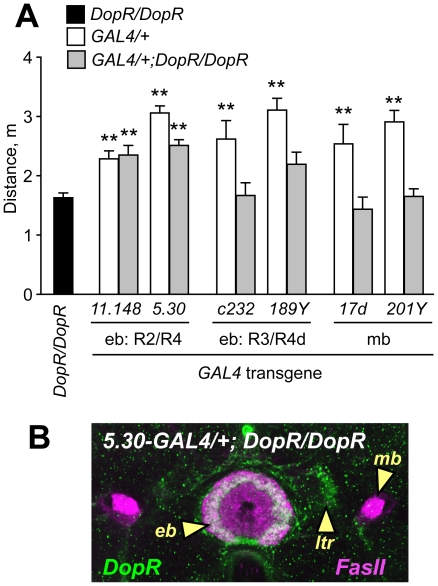
Genetic rescue of DopR mutant ethanol-induced hyperactivity by restricted expression of DopR in the ellipsoid body.
A. Distance traveled for animals homozygous for f02676 (DopR/DopR), and heterozygous for GAL4 transgenes to drive expression of DopR in patterns that include the ellipsoid body R2/R4 neurons (11.148, 5.30), R3/R4d neurons (c232, 189Y), or the mushroom bodies (17d, 201Y). Restored expression of DopR in the R2/R4 neuron patterns but not others resulted in increased ethanol-induced hyperactivity as compared to DopR/DopR (**P<0.01, 1 way ANOVA, Dunnett's multiple comparison test, n≥10). B. Rescuing strategy results in selectively localized DopR protein expression. Confocal section of an animal homozygous for f02676 and carrying the GAL4 enhancer trap 5.30, stained for DopR protein (green) and FasII (magenta). 5.30-GAL4 drives expression of DopR protein in the ring of the ellipsoid body (eb) and the lateral triangles (ltr), but not in the mushroom bodies (mb). DopR expression in the R2 neurons is indicated by the arrowhead.